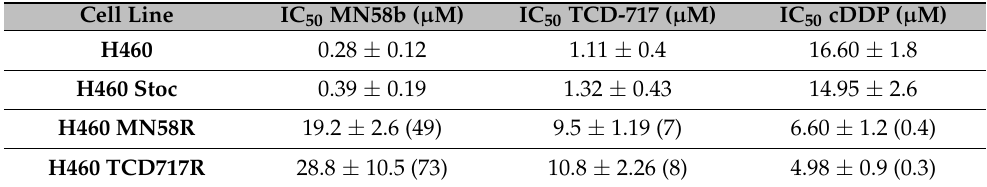
Table 2. Absence of cross-resistance between cisplatin and ChoK α inhibitors. NSCLC H460 cells and H460 cells made resistant to ChoK α inhibitors MN58b (H460 MN58R) or RSM-932A/TCD-717 (H460 TCD717R) were treated with different concentrations of MN58b, RSM-932A/TCD-717, and cisplatin. The concentration where 50% of the cell proliferation was inhibited (IC 50 ) was determined by MTT method. Data represent the mean ± SD of 3 to 9 independent experiments, each performed in quadruplicate. The fold induction of resistance is shown within